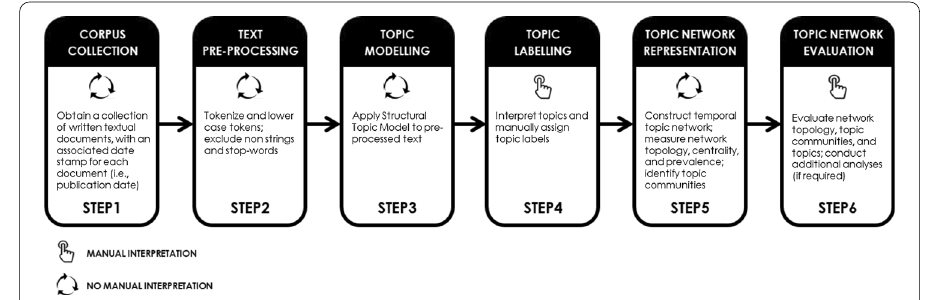
Fig. 1 Temporal network of associates topics—construction and